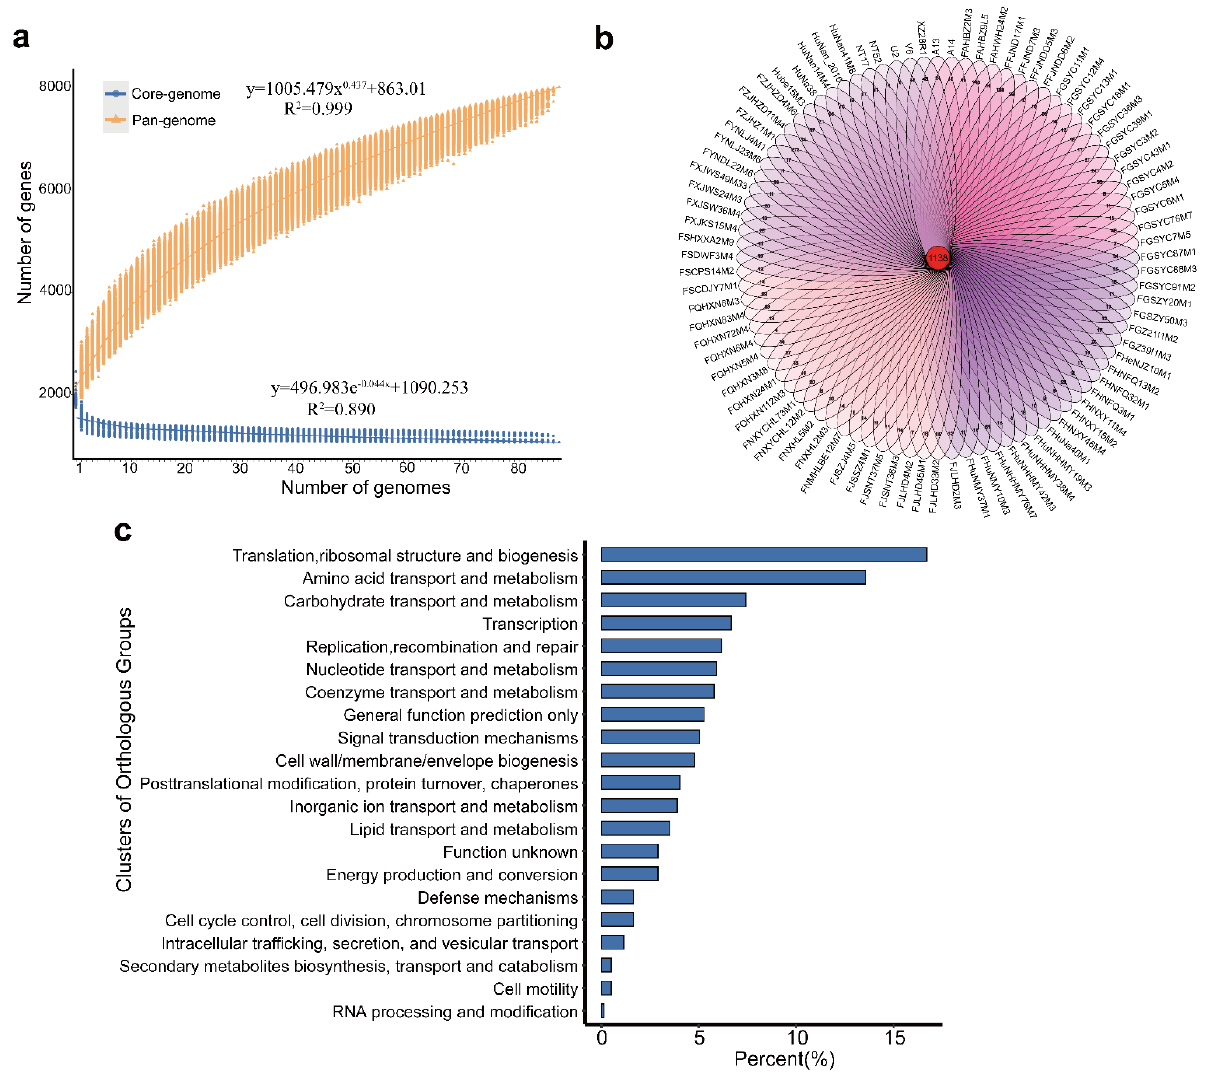
Figure 1. Pan − genome and core − genome of the 88 strains of B. pseudocatenulatum ( a ), Venn diagram representing core genes and unique genes of 88 B. pseudocatenulatum strains ( b ), Clusters of Orthologous Groups (COG) annotation of the core genes within 88 B. pseudocatenulatum ( c ).